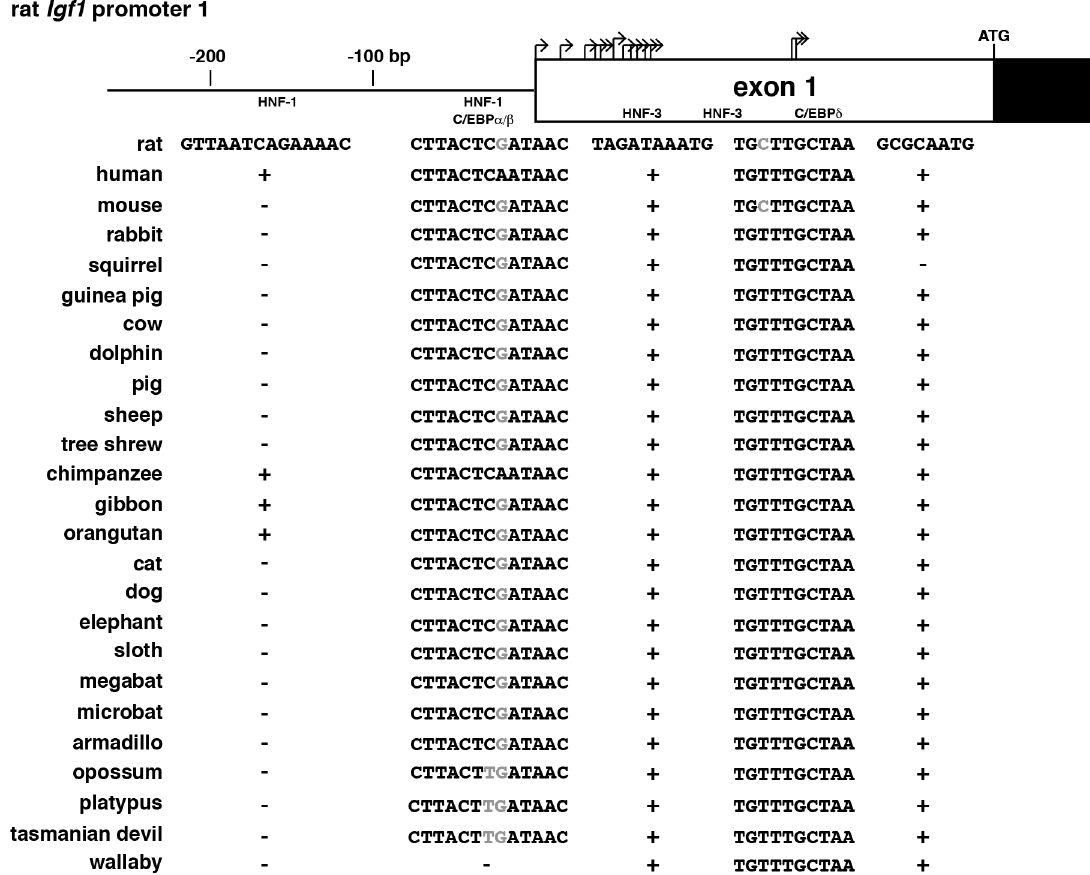
Fig 6. Comparison of IGF1 promoter 1. A . Schematicof rat Igf1 gene promoter1 and exon 1. Bent arrows indicate transcription start sites in exon 1, and the locationof the ATG codon is labeled.CodingDNA is in black and noncodingin white. The relativefrequencyof transcription start site usageis depictedby the heightof each bent arrow. The locationsof binding sites for the transcription factors HNF-1, C/EBP α / β , HNF-3, and C/EBP δ are indicated. The presenceof identicalsites in different speciesis indicatedby + for each transcription factor site, and the absenceis depictedby -; altered nucleotides are shadedin gray.